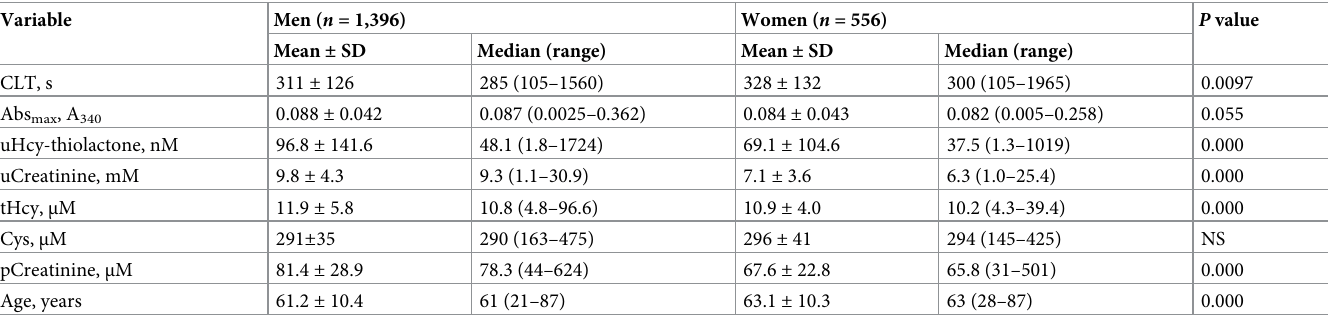
Table 1. Baseline plasma fibrin clot lysis tome (CLT), maximum absorbance (Abs max ), and other variables in CAD patients stratified by sex. Variable Men ( n =